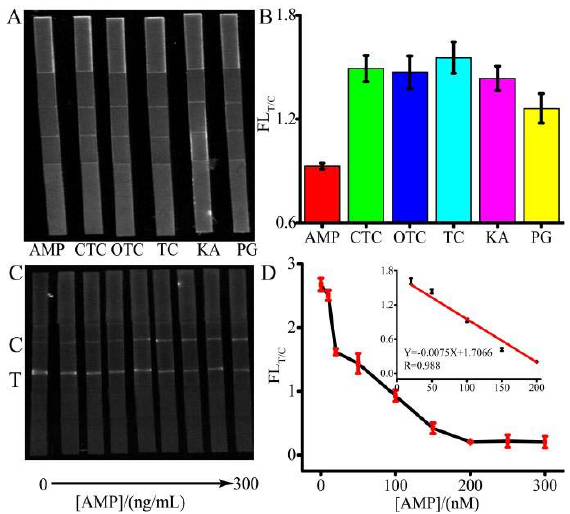
Figure 5. ( A ) Image of the selectivity of the proposal. ( B ) FL T/C indicates the FL intensity ratio of the T ‐ line/C ‐ line. ( C ) Image of the intensity corresponding AMP concentrations. ( D ) The FL intensity ratio was between T ‐ line and C ‐ line with different AMP concentrations. Inset shows a linear range from 10 to 200 ng/L. FL T/C indicates the FL intensity ratio of T ‐ line/C ‐ line.